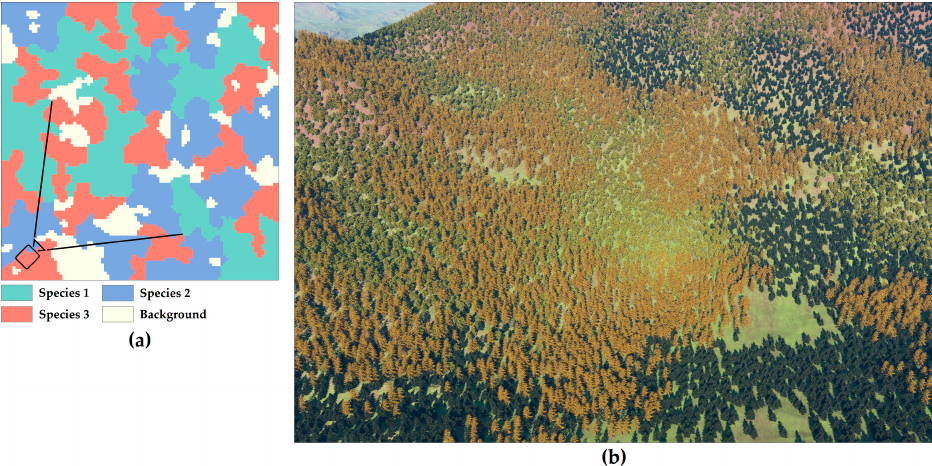
Figure 10. ( a ) A virtual forest landscape with the following input: (cid:1842) (cid:2869) = (cid:1842) (cid:2870) = (cid:1842) (cid:2871) = 30%, (cid:1842)(cid:1840) (cid:2869) = 5, (cid:1842)(cid:1840) (cid:2870) = 10, (cid:1842)(cid:1840) (cid:2871) = 15, (cid:1839)(cid:1845)(cid:1835) (cid:2869) = 2.5 and (cid:1839)(cid:1845)(cid:1835) (cid:2870) = (cid:1839)(cid:1845)(cid:1835) (cid:2871) = 2.0. ( b ) The rendering result of tree distribution based on panel ( a ).